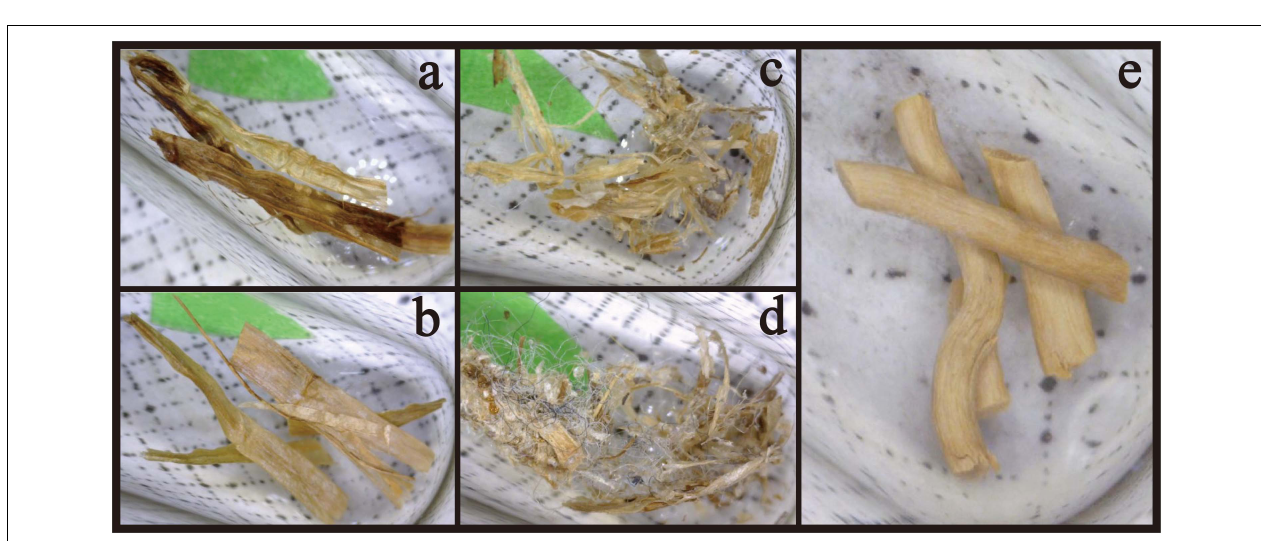
FIGURE 2 | Profile of section CQ. (A) section CQ1, (B) section CQ2, and (C) overall profile of section CQ. (a–d) are details of section CQ.